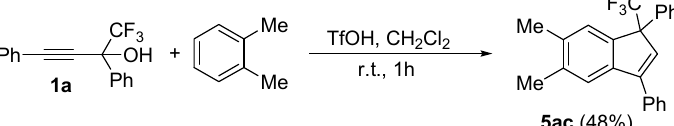
Table 4. TfOH-promoted reaction of 1 with p -xylene; reaction conditions: TfOH, CH 2 Cl 2 , molar ratio of 1 : p -xylene:TfOH = 1:1.1:1.5, room temperature, 1